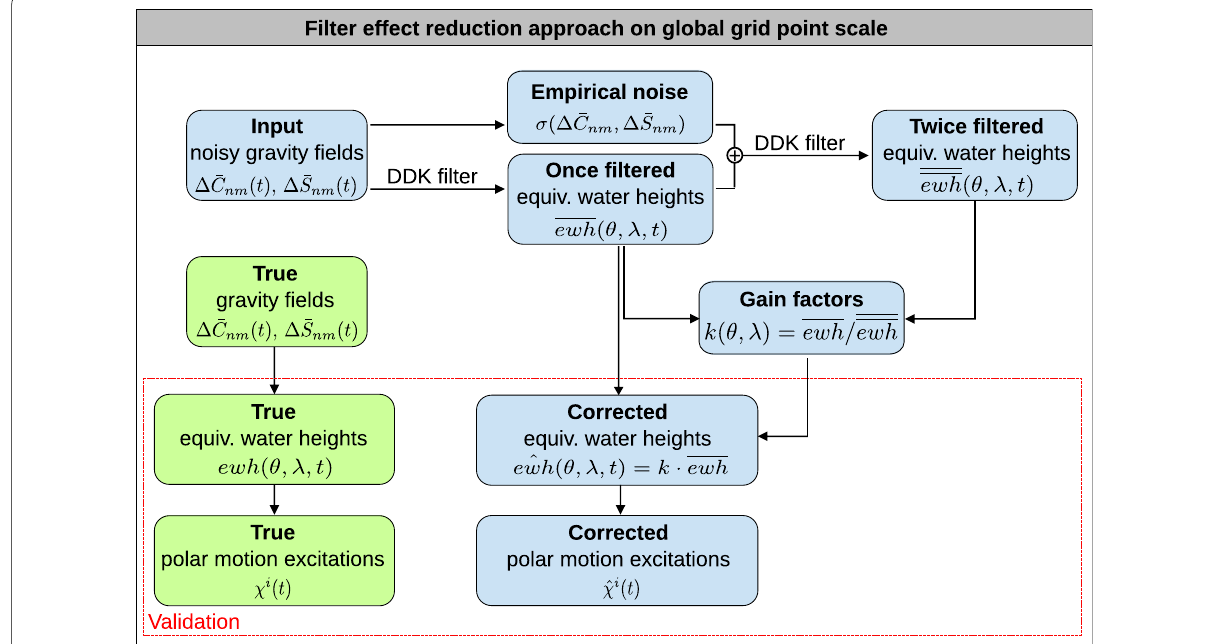
Fig. 2 Flow chart of the filter effect reduction approach on global grid point basis. The true data are displayed in green, whereas the noisy data are displayed in